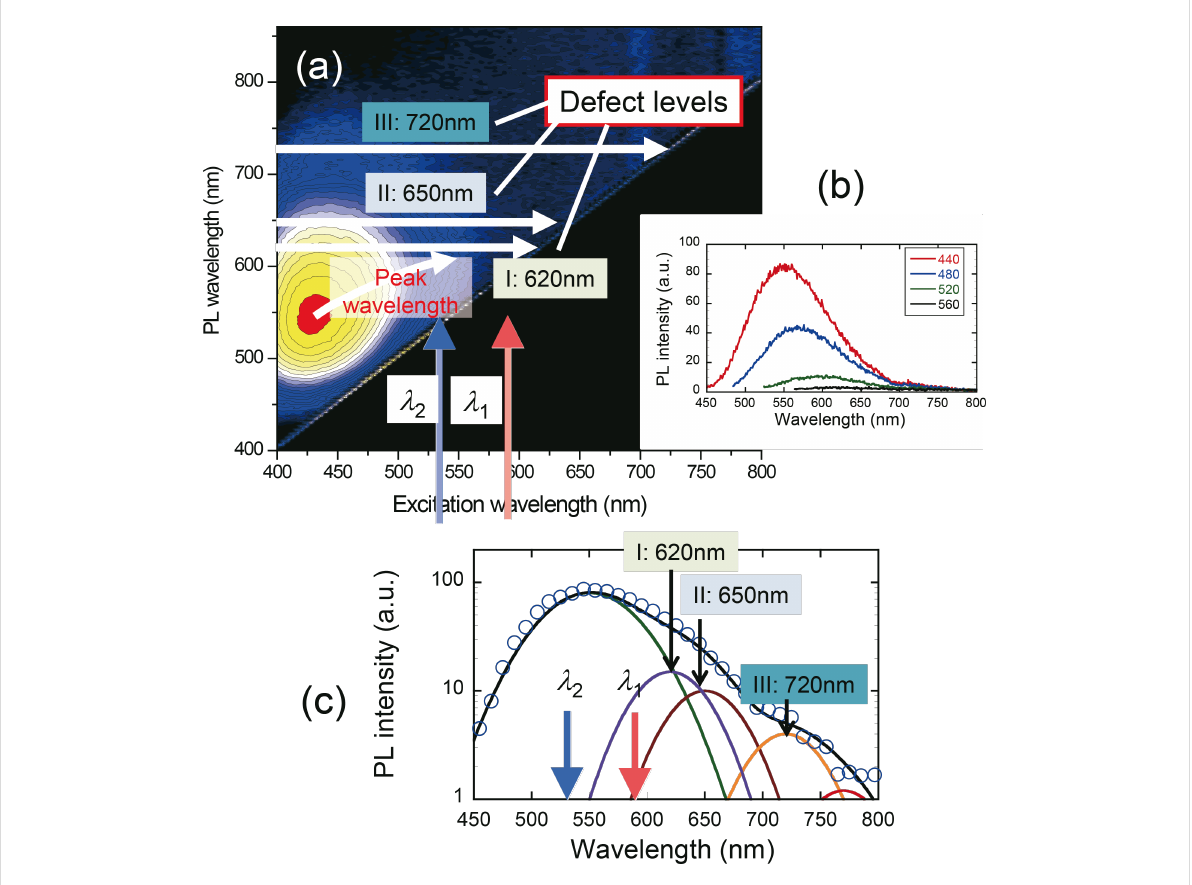
Figure 2: (a) Dependence of PL spectra on excitation wavelength. (b) PL spectra obtained with excitation wavelengths of 440, 480, 520, and 560 nm. (c) Fitted PL spectrum (the same as the red curve in (b)) and several Lorenz curves with peak wavelengths of 550, 620, 650, and 720 nm.